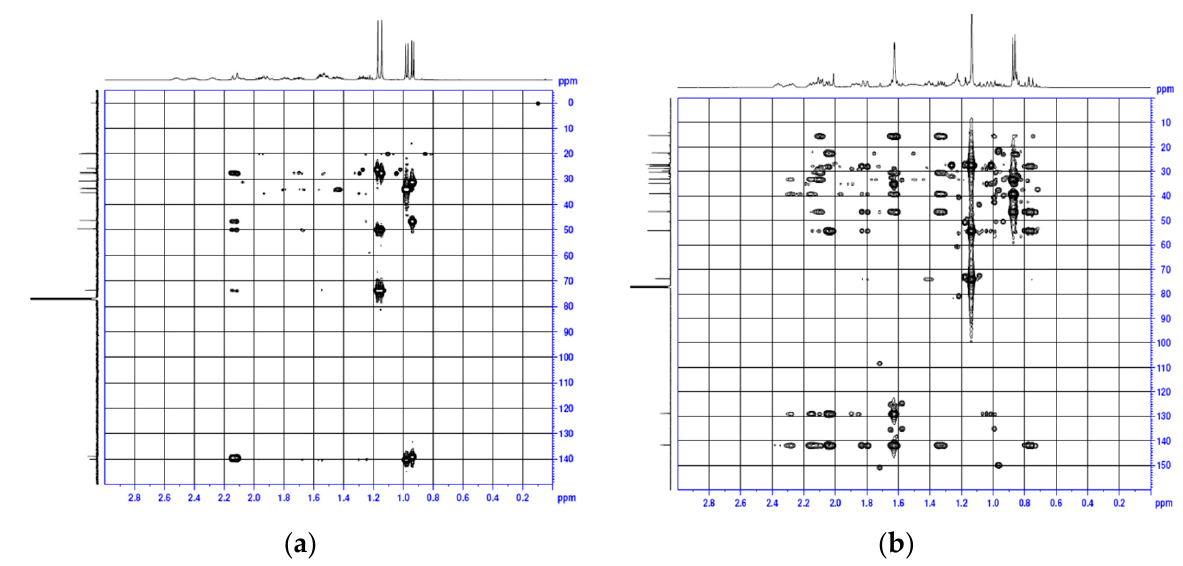
Figure 3. HMBC spectra of guaiol and bulnesol. ( a ) Guaiol; ( b ) Bulnesol. β -Elemol: Light yellow oil, EI-MS m/z: 79, 93, 105, 119, 133, 147, 161, 175, 189, Bulnesol (guai-1(10)-en-11-ol): Colorless oil, EI-MS m/z: 93, 105, 107, 119, 133, 161, 189, 204, 222 [M+]. Molecular formula: C 15 H 26 O. IR ν max cm − 1 : 3434 (OH), 2967 (C-H), 2933